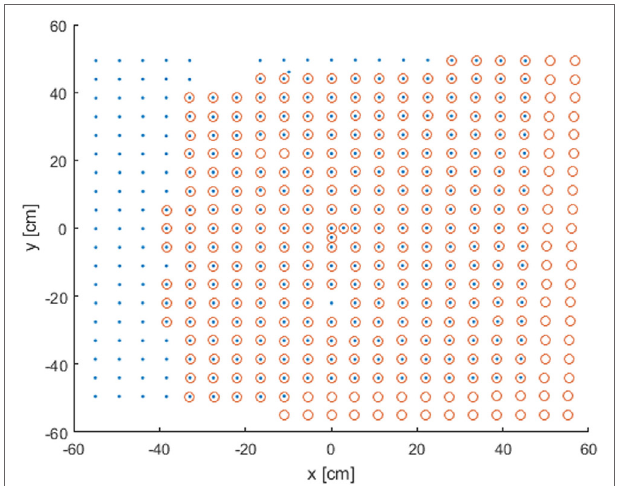
FIgURe 6 | Calibration pattern after the completion of the calibration procedure obtained by both cameras (blue dots and red circles). Units correspond to centimeters along the flat water